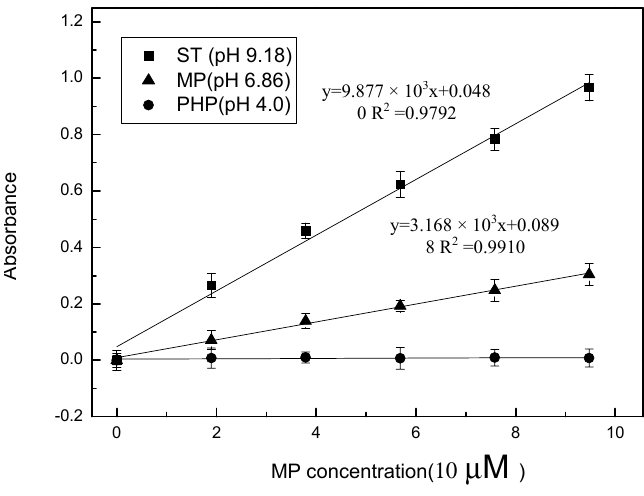
Figure 4. Optical biosensor response at different pH buffers. The enzymes were immobilized on Ni-NTA agarose and the enzymatic products were filtrated into the optical cell using a home-made filtrating system.